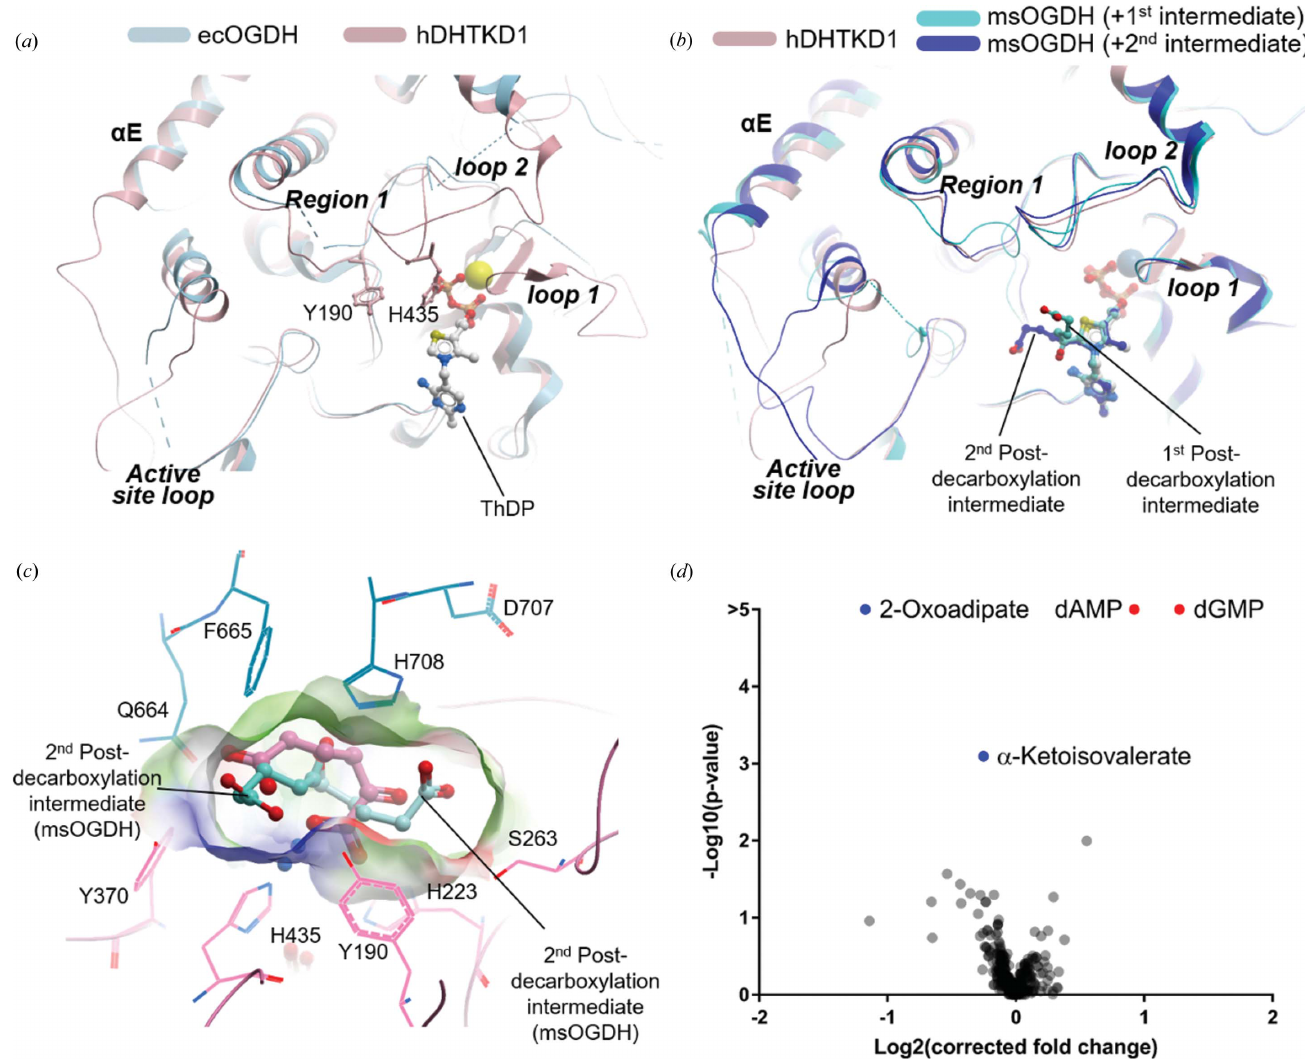
Figure 2 Substrate binding pocket of hDHTKD1. ( a ) Aview of the active site from the hDHTKD1 structure (pink ribbon) bound with ThDP (sticks, white carbon atoms) and Mg 2+ (yellow), overlaid with the ecOGDH structure in the apo form (light blue ribbon; PDB code 2jgd), to highlight structural differences in various loop regions. ( b ) The same hDHTKD1 active-site view as in panel ( a ), overlaid with msOGDH structures in complex with the first post- decarboxylation intermediate (cyan ribbons for proteins, sticks with cyan carbon atoms for ligands; PDB code 3zht) and second post-decarboxylation intermediate (blue ribbons for proteins, sticks with blue carbon atoms for ligands; PDB code 3zhu). ( c ) The hDHTKD1 substrate pocket is lined by residues from both subunits of the homodimer (pink and blue lines). Overlaid in this pocket is the putative 2OA ligand (pink sticks) modelled in our density (Fig. S6) and the post-decarboxylation intermediates (cyan sticks) bound to the msOGDH structures. ( d ) The hDHTKD1–metabolite interactome as determined by MIDAS . hDHTKD1 significantly depleted 2OA and (cid:2) -oxoisovalerate, and enriched dAMP and dGMP. The cutoff for significance was p < 0.05 and q <